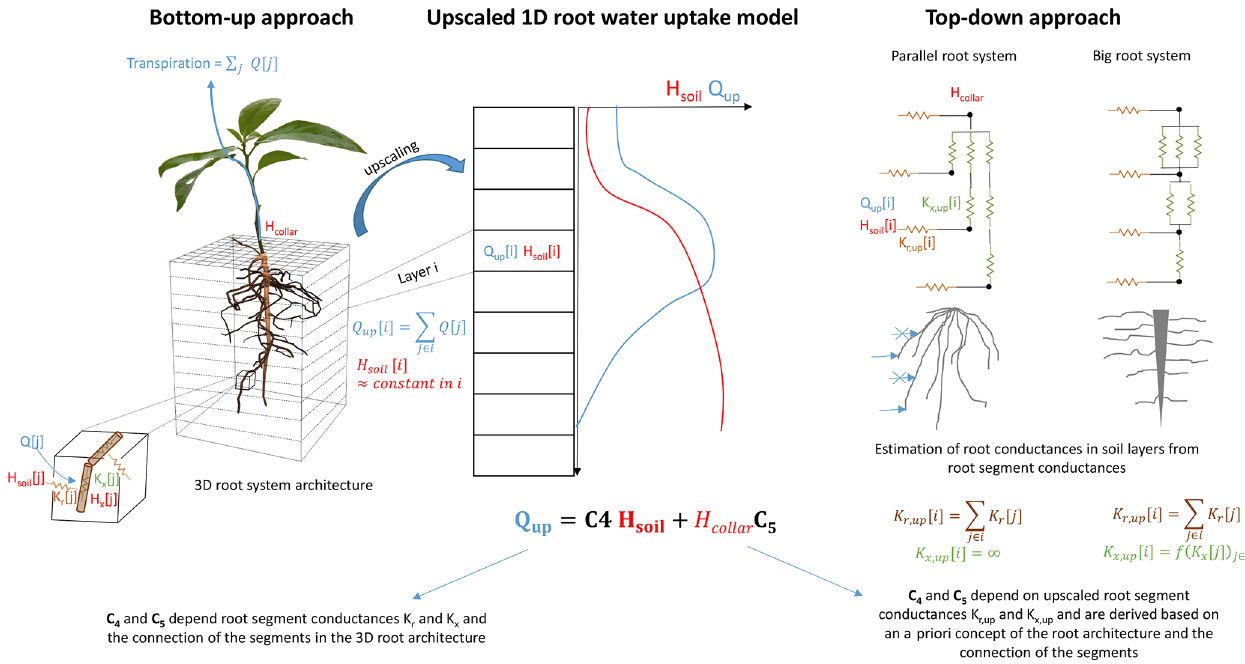
Figure 1. Bottom-up approach versus top-down approaches for a parallel and a big root system model to derive and parameterize an upscaled one-dimensional root water uptake